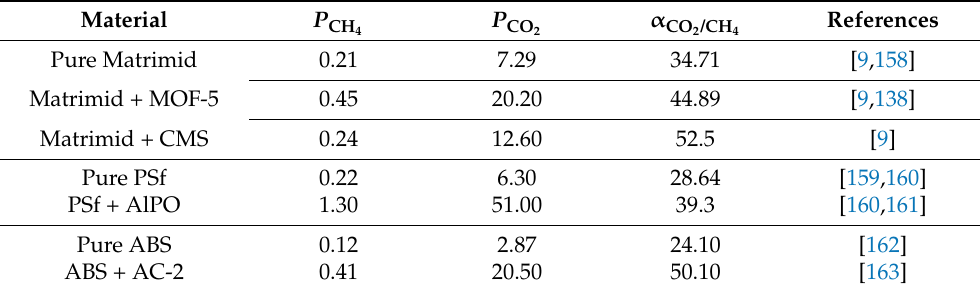
Table 5. Promising MMMs for purification of natural gas.